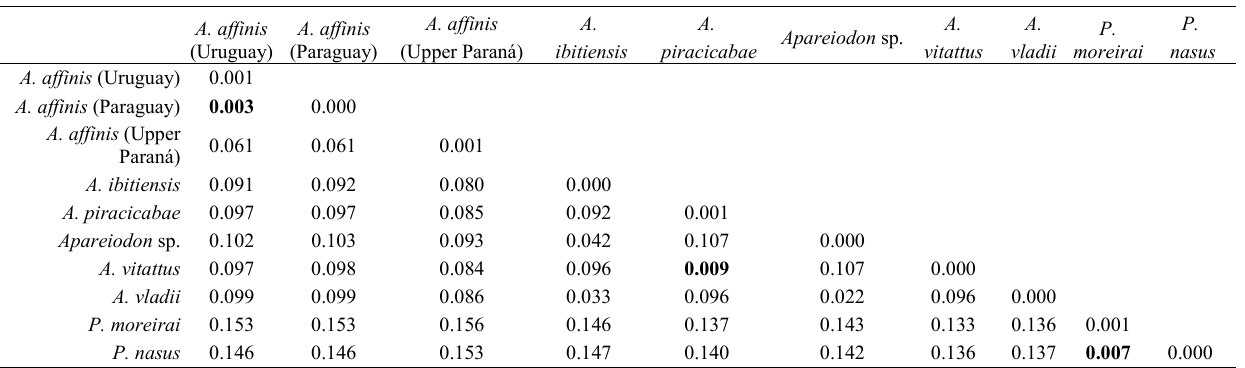
Table 2. Nucleotide divergence among species: The highlighted numbers represent K2P differences lower than 2% between species.